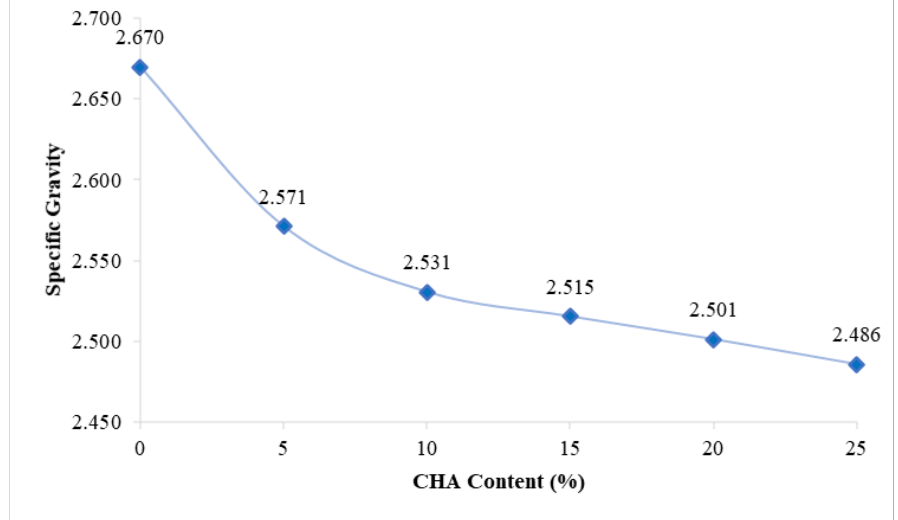
Figure 6. The specific gravity of the clay – CHA mixture.